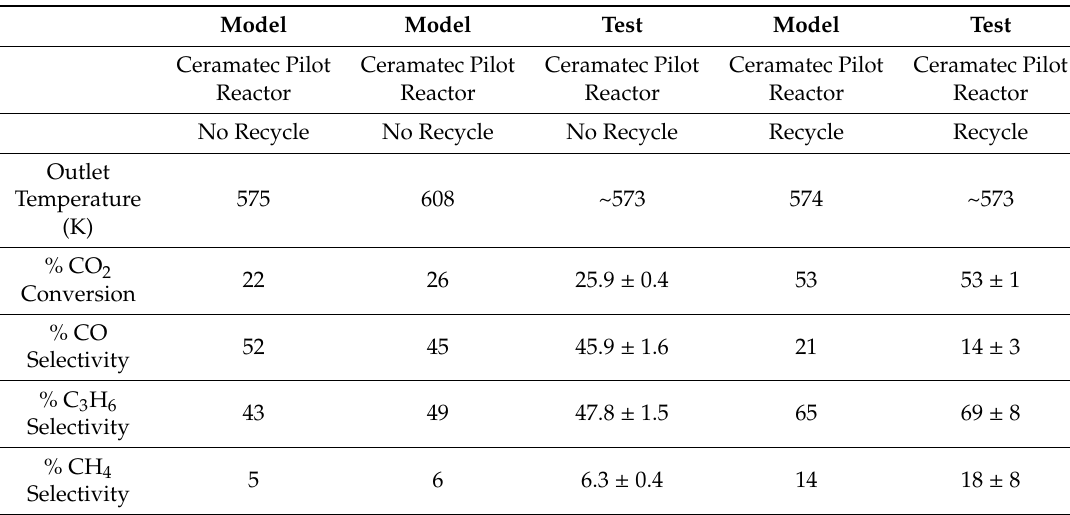
Table 2. 3D kinetic modeling predictions for product selectivity and CO 2 conversion under single pass feedstock conditions and recycling conditions compared to the average measured for the rector prototype. Single pass feedstock conditions at GHSV of 4 × 10 − 4 L / s-g and recycling conditions